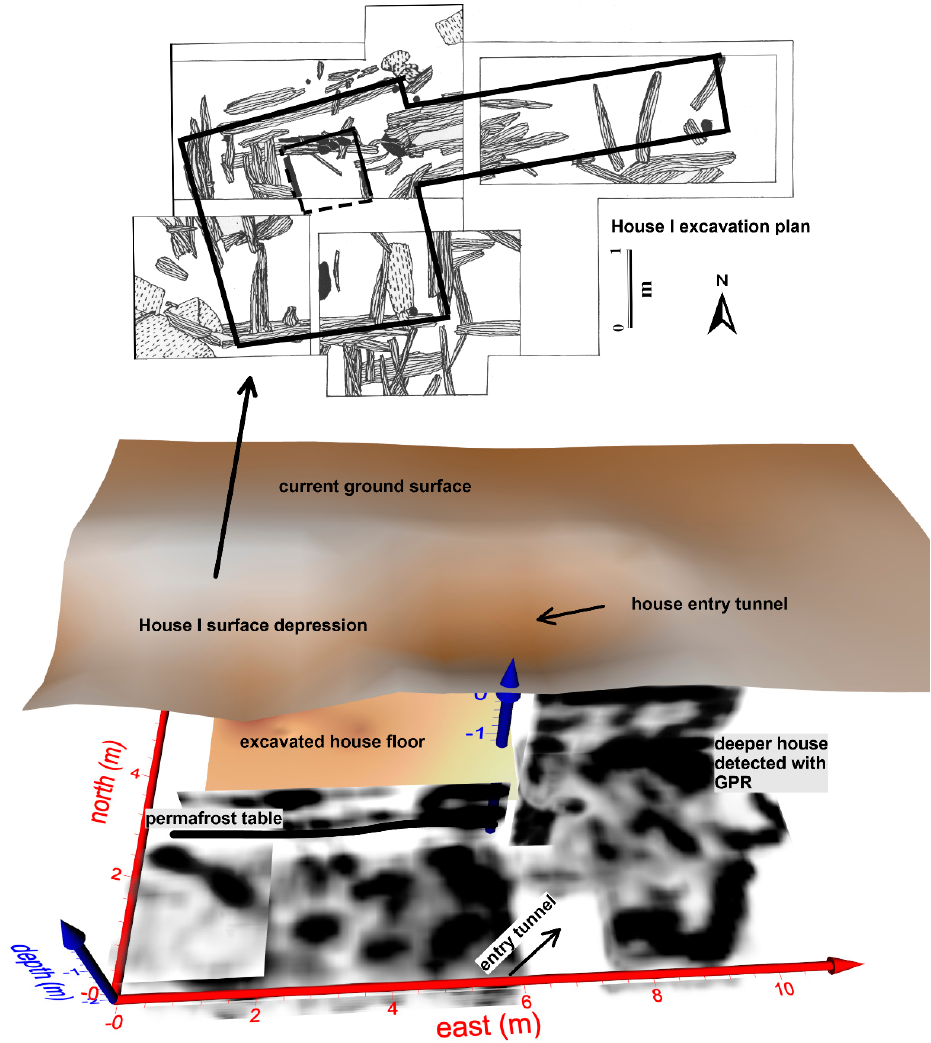
Figure 13. House I. The surface depression designated House I was excavated to the house floor and dated to the 19th century. Permafrost encountered in the deepest portions of the excavation was consistent with an interface identified in the GPR survey around the depression. The GPR survey also showed an additional occupation in the frozen layer. Similar features were detected in other areas of the village site at comparable depths. The darker colors represent higher amplitude reflections. Our excavated cases at this site indicate that wood framing timbers are the cause of these anomalies.